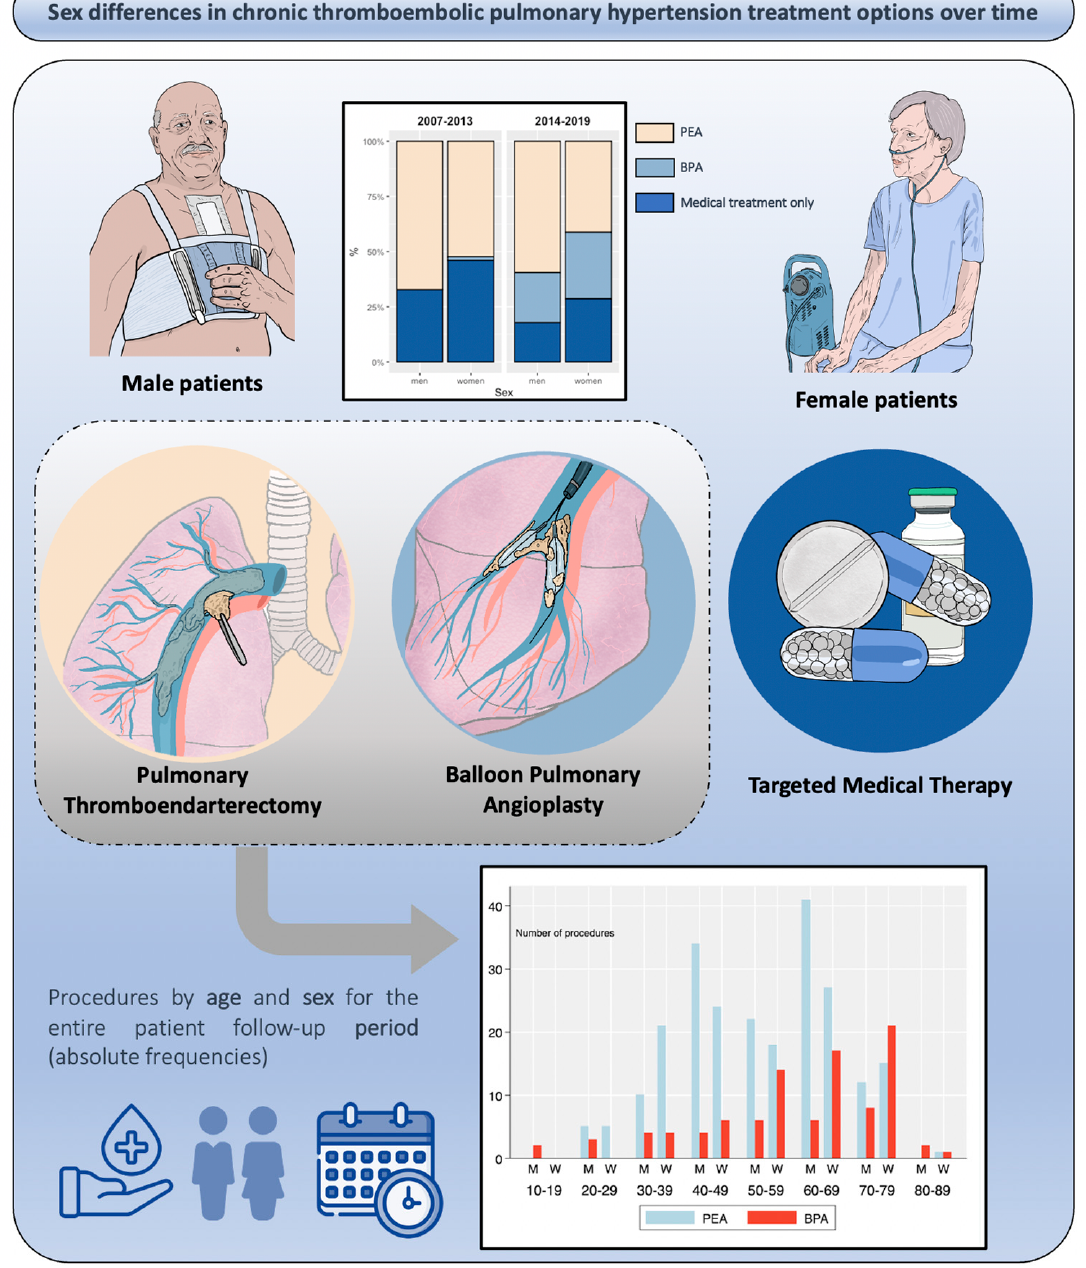
Figure 3. Treatment options over time (2007–2013, n = 118; 2014–2019, n = 335) by sex (relative frequencies). Procedures by age and sex for the entire patient follow-up period (absolute frequencies).